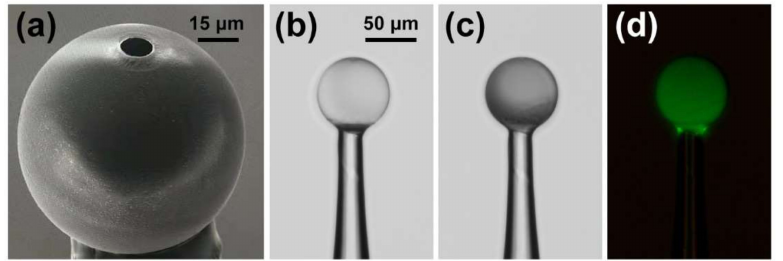
Figure 2. ( a ) SEM image of the perforated HGMS with a 10 µ m diameter microhole; ( b ) Optical mi- croscopic images of the HGMS ( b ) before and ( c ) after LC modification; ( d ) Fluorescence microscopic image of the HGMS immobilized FITC-cTnI